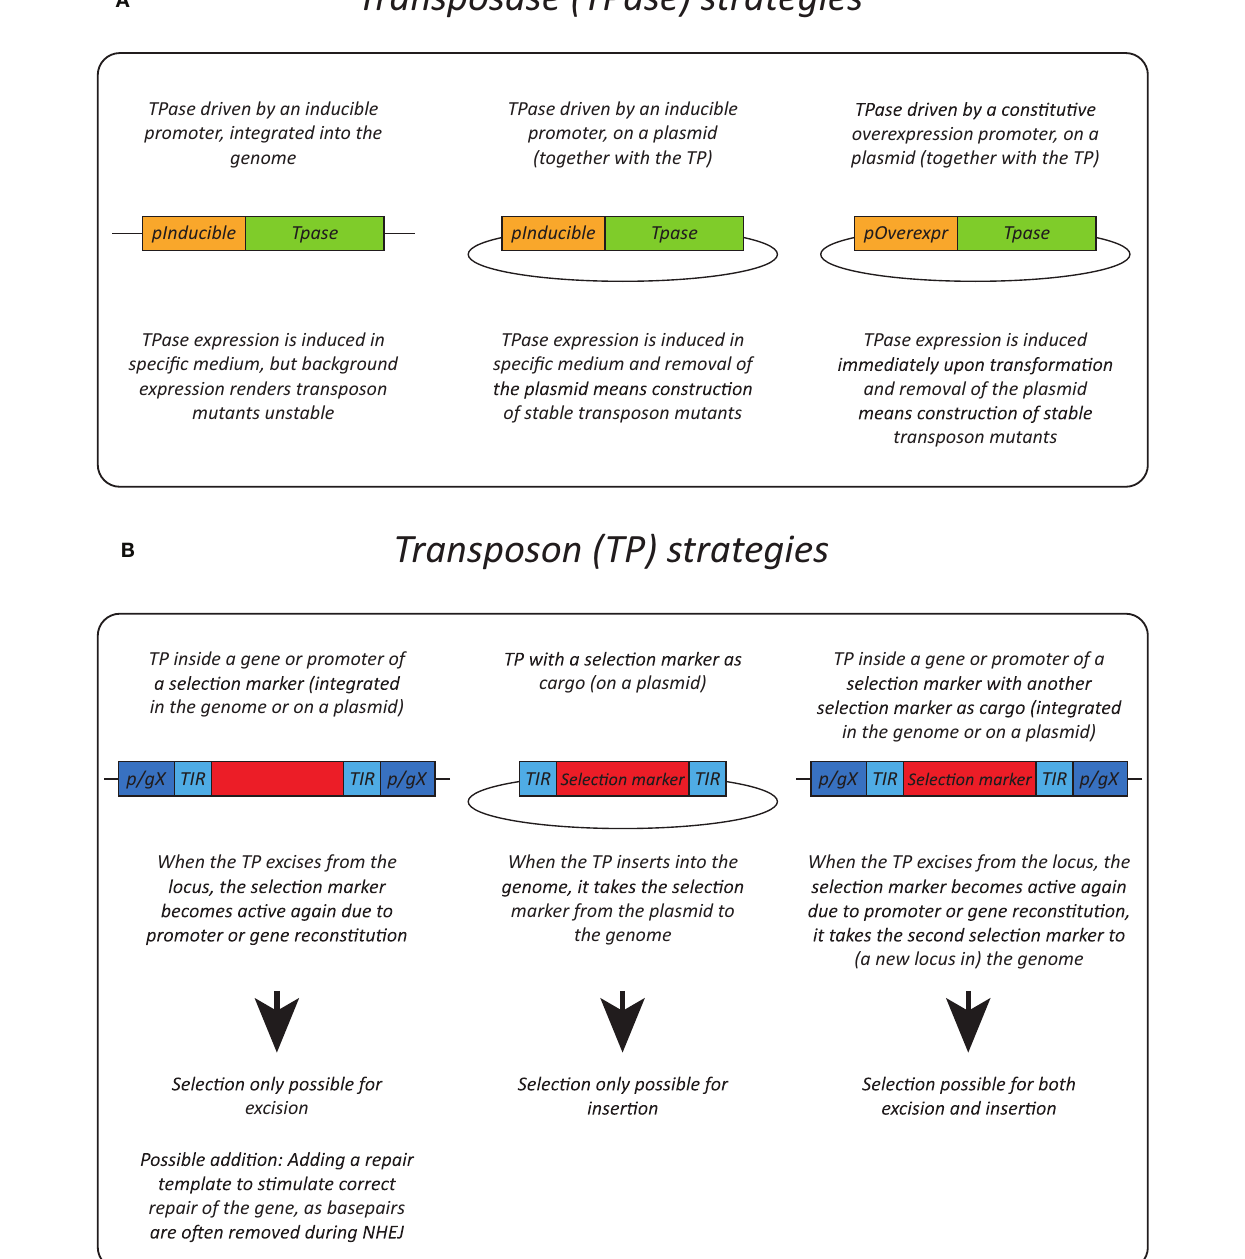
mitochondria and were sufficient to sustain several generations without the presence of the encoding genes. Furthermore, some genes that were marked as non-essential inferred from deletion collection screenings were found to be essential by non-deleted in the deletion collection (Guo et al., 2013). Both